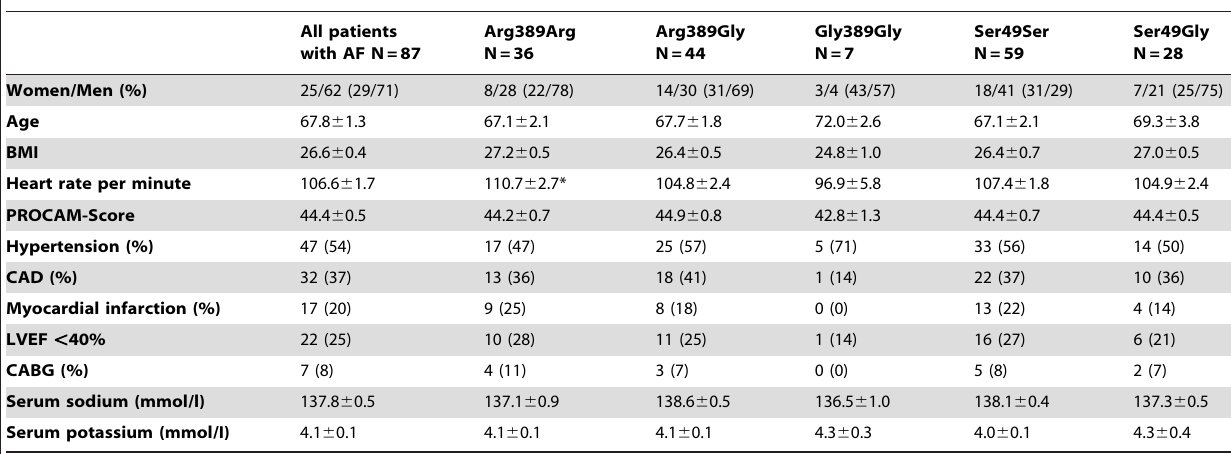
Table 1. Baseline characteristics in patients with different b 1 AR variants.